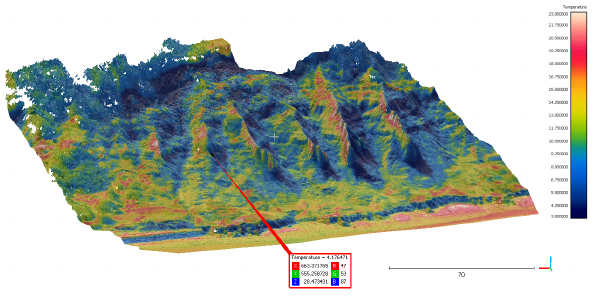
Figure 9. α -blending with infrared and visible